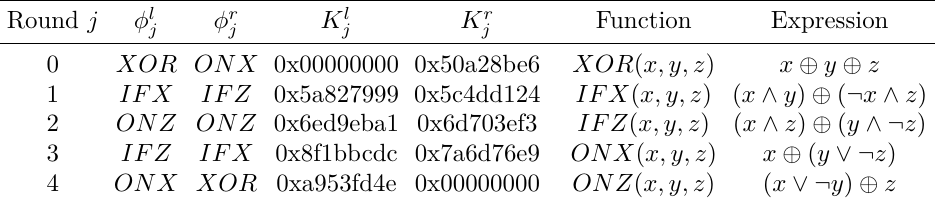
Table 3: Boolean Functions and Round Constants in